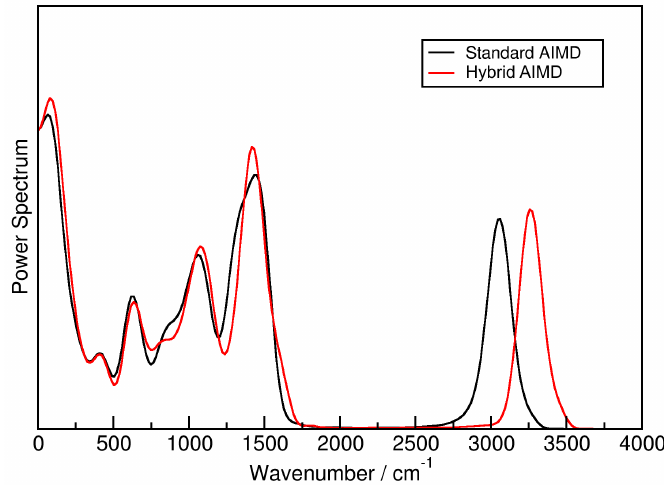
Figure 4. Power spectra of of the ionic liquid [EMIm][OAc], computed from the standard AIMD simulations (black line) [59–61] and the HyAIMD simulations performed here (red